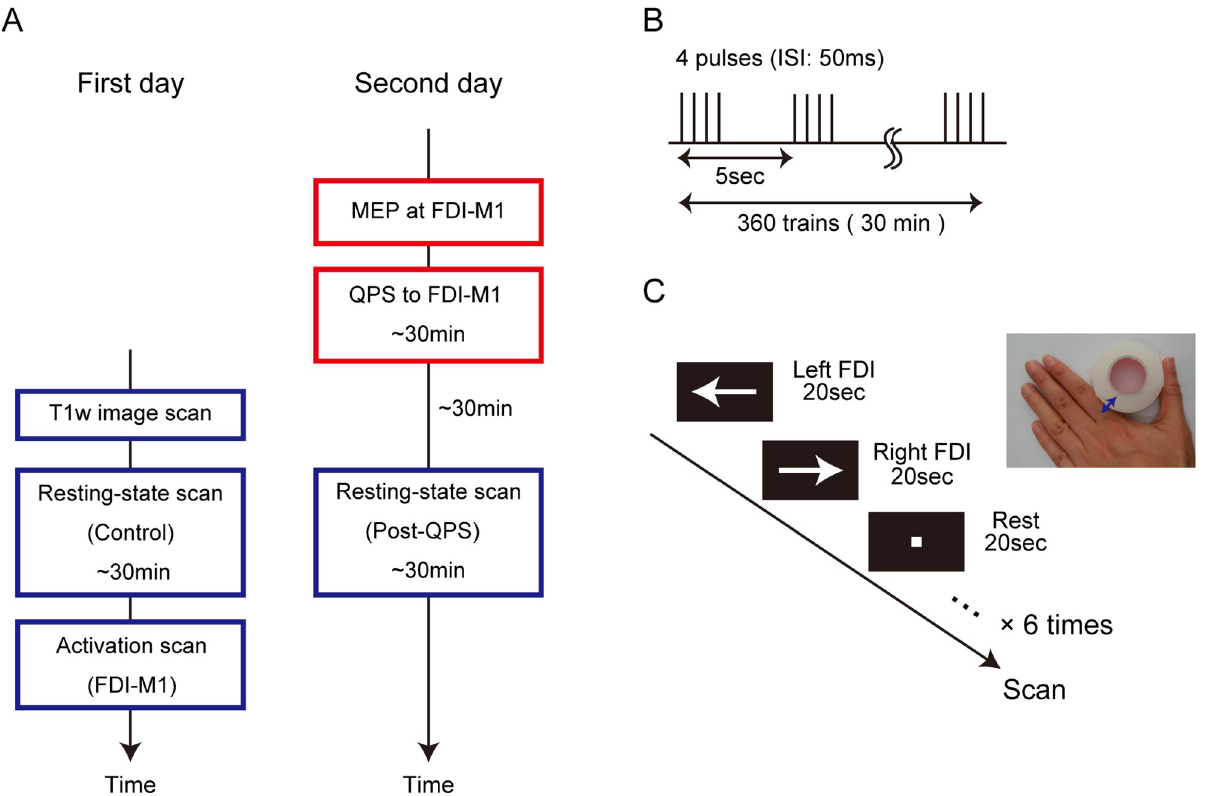
Fig 1. Overview of the experimental design. (A) On the first day, the T1-weighted image and resting-state (control) scans were obtained. On the second day, MEP after single-pulse TMS was measured to identify the FDI representation in the M1. Then, QPS was delivered to the FDI-M1 region for 30 min to induce cortical plasticity. After an approximately 30 min break, the resting-state scan (post-QPS) was administered. (B) A QPS sequence that consisted of 360 trains of quadripulse rTMS at 50 msec inter-stimulus interval (ISI) with an inter-train interval of 5 sec. (C) A finger movement task in a localizer scan to identify the M1 for the FDI. The subjects were instructed to move their left or right FDI at 2Hz as the arrows blinked for 20 sec each, followed by resting for 20 sec. The left-right-rest cycle was repeated six times.